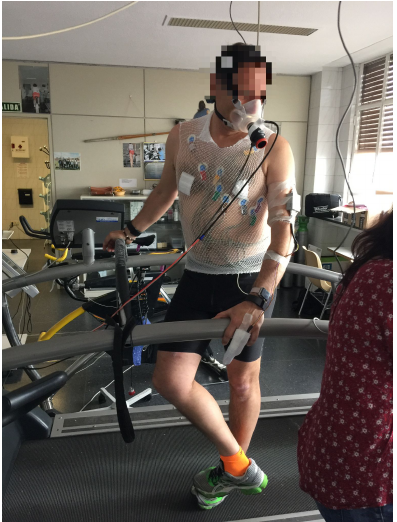
Figure 1. Performance athlete during the exercise stress test on the treadmill. The HR device is placed on the wrist, the electrodes are placed for electrocardiographic recording, and the mouthpiece is for the gas flow